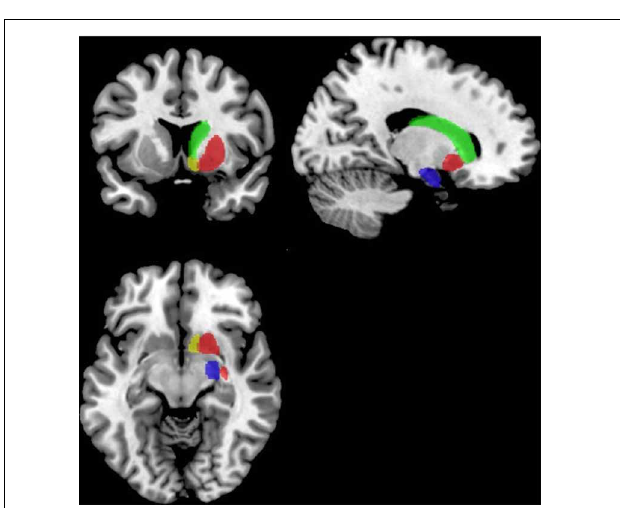
FIGURE 3 | Masks for the striatum and amygdala. The NAcc is shown in yellow, the caudate in green, the putamen in red and the amydgala in blue displayed on the right hemisphere of a standard brain in neurological convention (left is left).